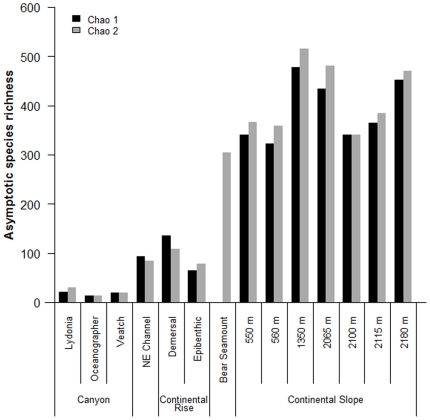
Asymptotic species richness estimates.Comparison of the asymptotic species richness estimates (Chao 1 and Chao 2) for 5 different sub-regions in the deep-sea region of the Gulf of Maine. The Chao 1 estimate for Bear Seamount could not be calculated due to lack of singletons within the data.